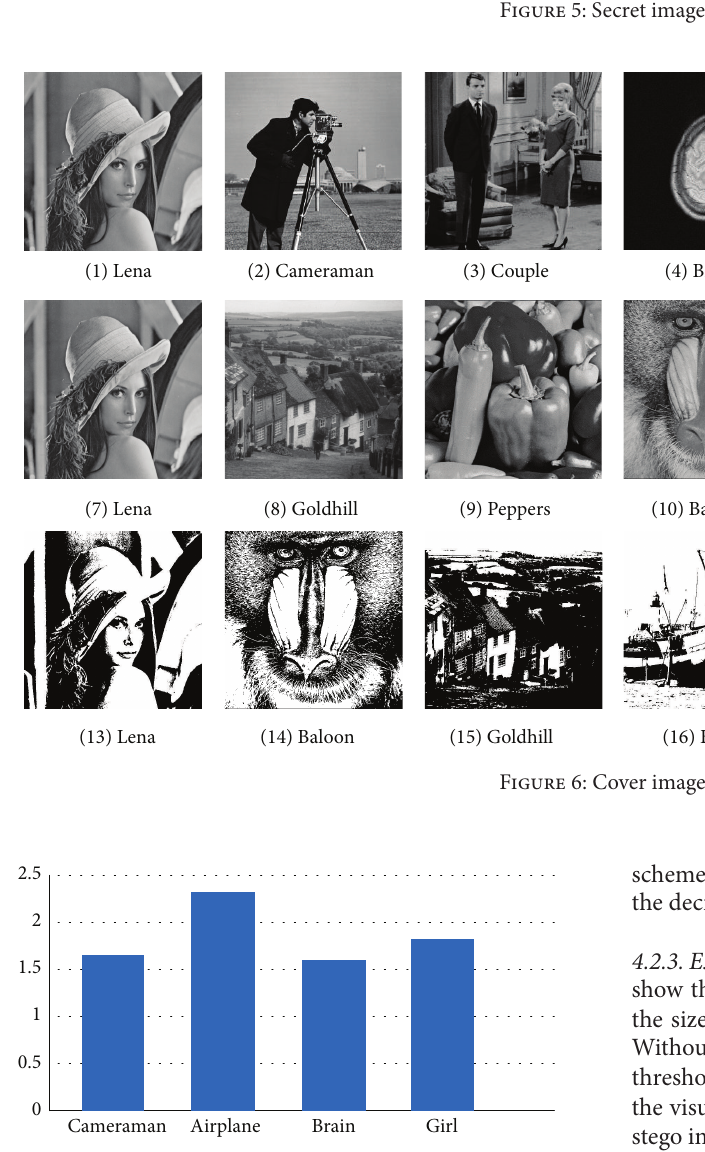
Figure 7: The value of